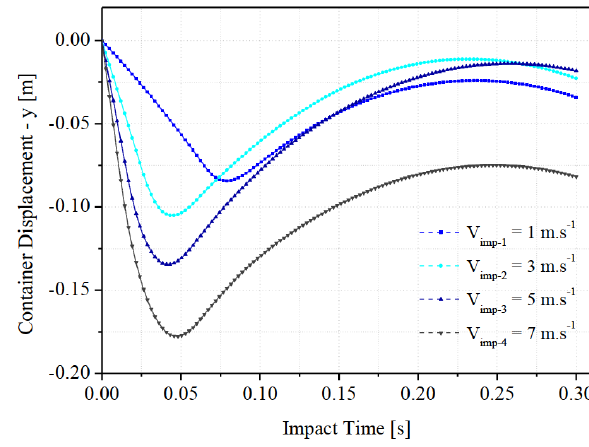
Figure 15: Displacement extent on the longitudinal direction (x-axis) of the container